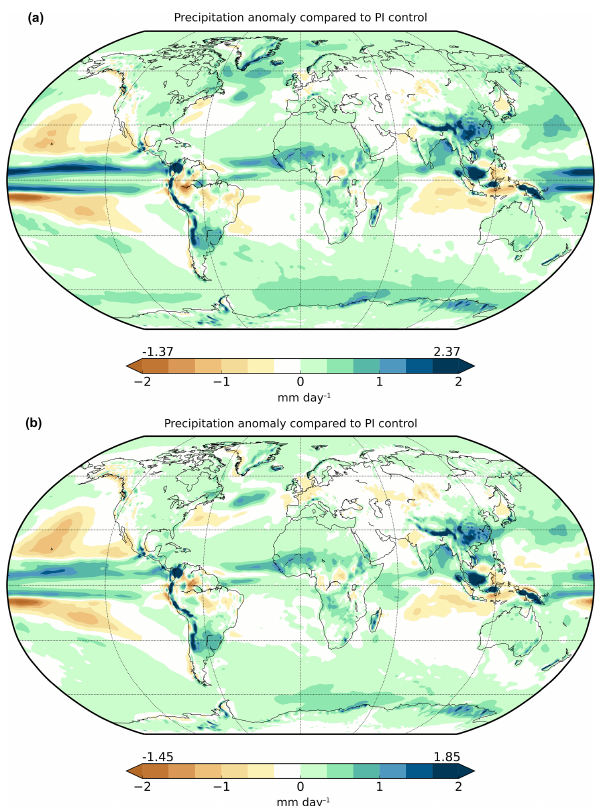
Figure 10. The annual precipitation anomaly between the E oi 400 P mid-Pliocene simulation (cid:104) 2691 , 2720 (cid:105) and (a) the PI control E 280 P (cid:104) 5131 , 5160 (cid:105) and (b) the modern control E 400 P (cid:104) 1931 , 1960 (cid:105) . Anomaly is defined as Pliocene minus control. The (cid:104)(cid:105) denotes the range of model years over which the climatology was computed.